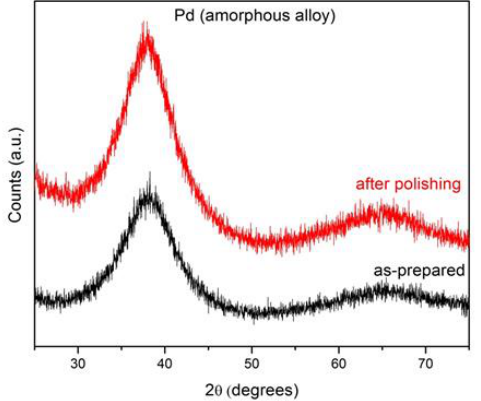
Figure 3. XRD patterns of Pd amorphous alloy in the as-prepared state and after polishing [25], reproduced with permission from Elsevier, 2019.